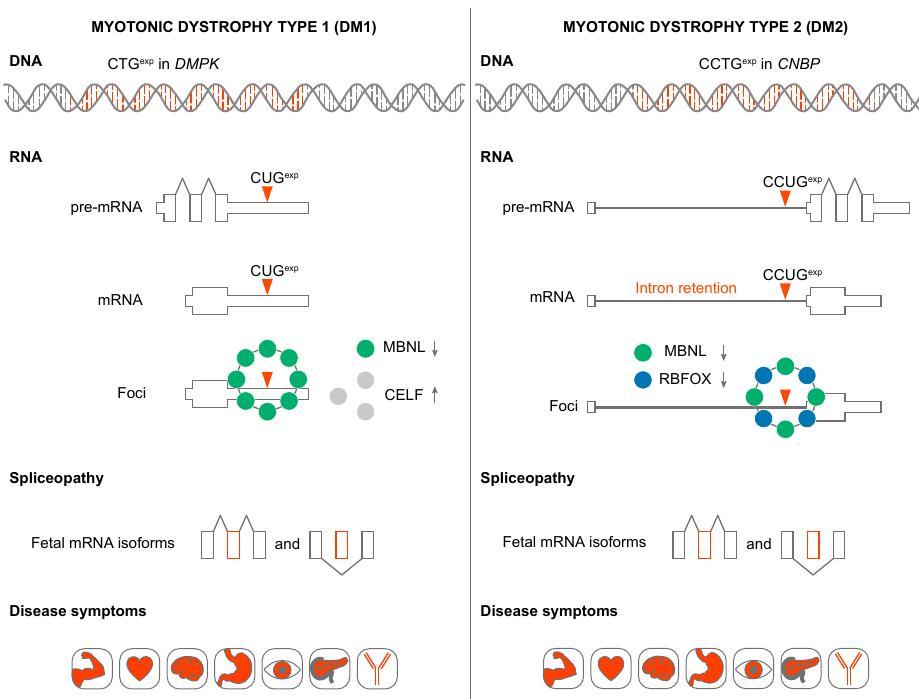
Figure 3. Models of DM1 and DM2 disease mechanisms. CTG exp and CCTG exp in the DMPK and CNBP genes produce pre-mRNA transcripts containing expanded CUG and CCUG repeats. DMPK pre-mRNA is correctly spliced whereas CCUG exp triggers CNBP intron 1 retention. mRNAs with C(C)UG exp sequester Muscleblind-like (MBNL) and RBFOX (in DM2) alternative splicing factors. In addition, CUG exp increase CUGBP Elav-Like Family Member 1 (CELF1) splicing factor stability